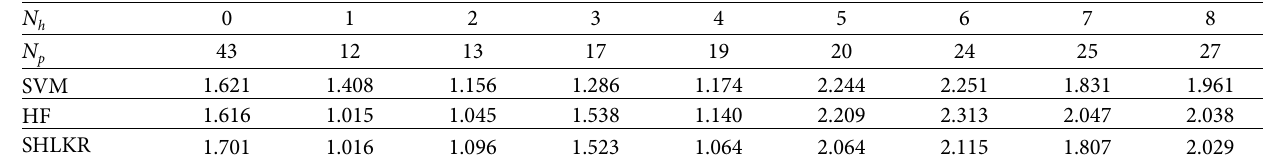
Table 2: RMSE comparison using different number of historical records.